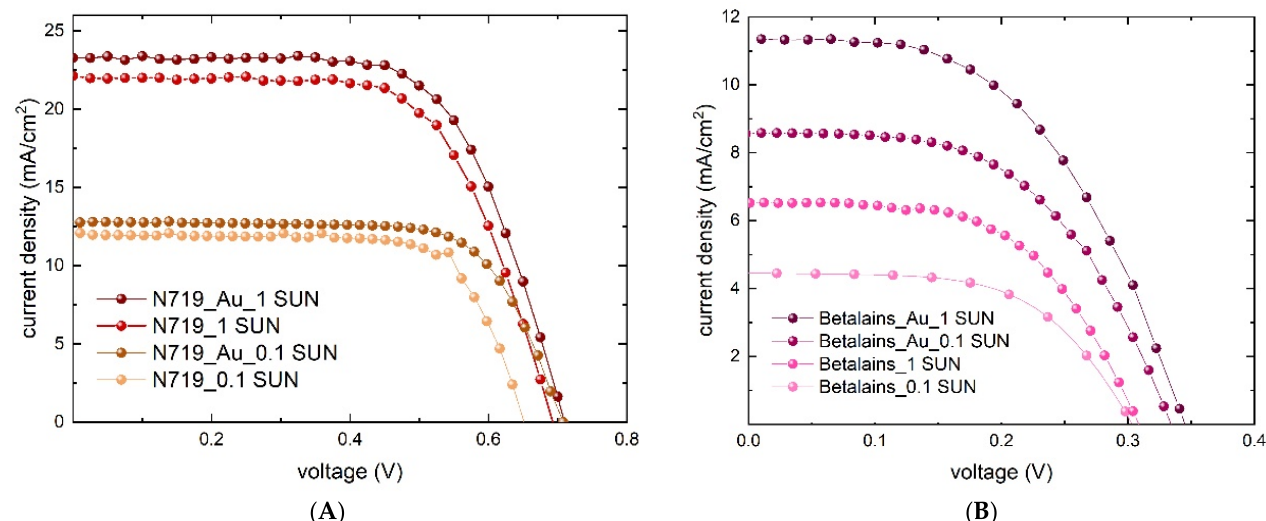
Figure 7. JV measurement of the best DSSC device containing the reference TiO 2 and the one mixed with Au@TiO 2 with ( A ) N719 and ( B ) betalains. Table 2. Photovoltaic parameter comparison between TiO 2 reference devices and Au@TiO 2 - containing device. Relative increment is calculated as an average.